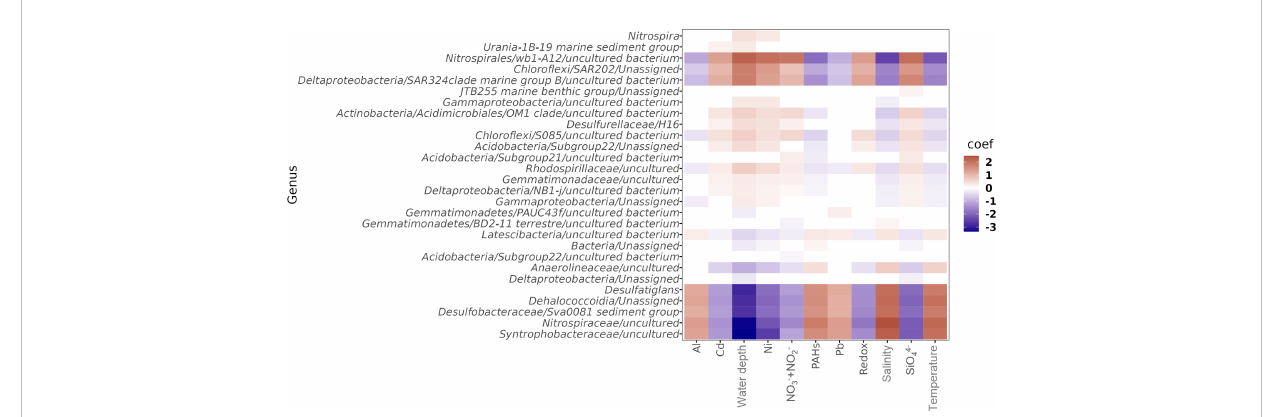
FIGURE 5 Analysis of multivariable associations of microbial genera with environmental variables related with the community structure changes in PFB sediments. These genera were present in 25% of the total samples.